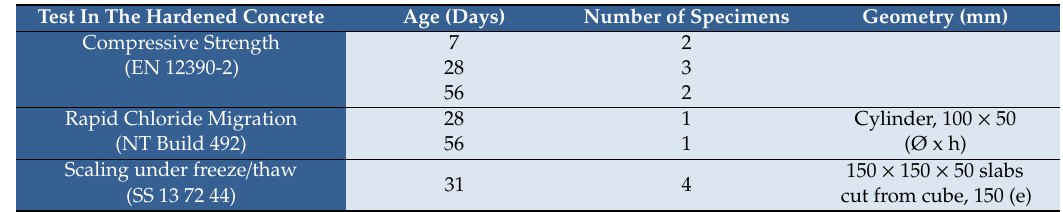
Table 3. Specimens casted, geometry of the moulds and age of testing of the hardened concrete. Test In The Hardened